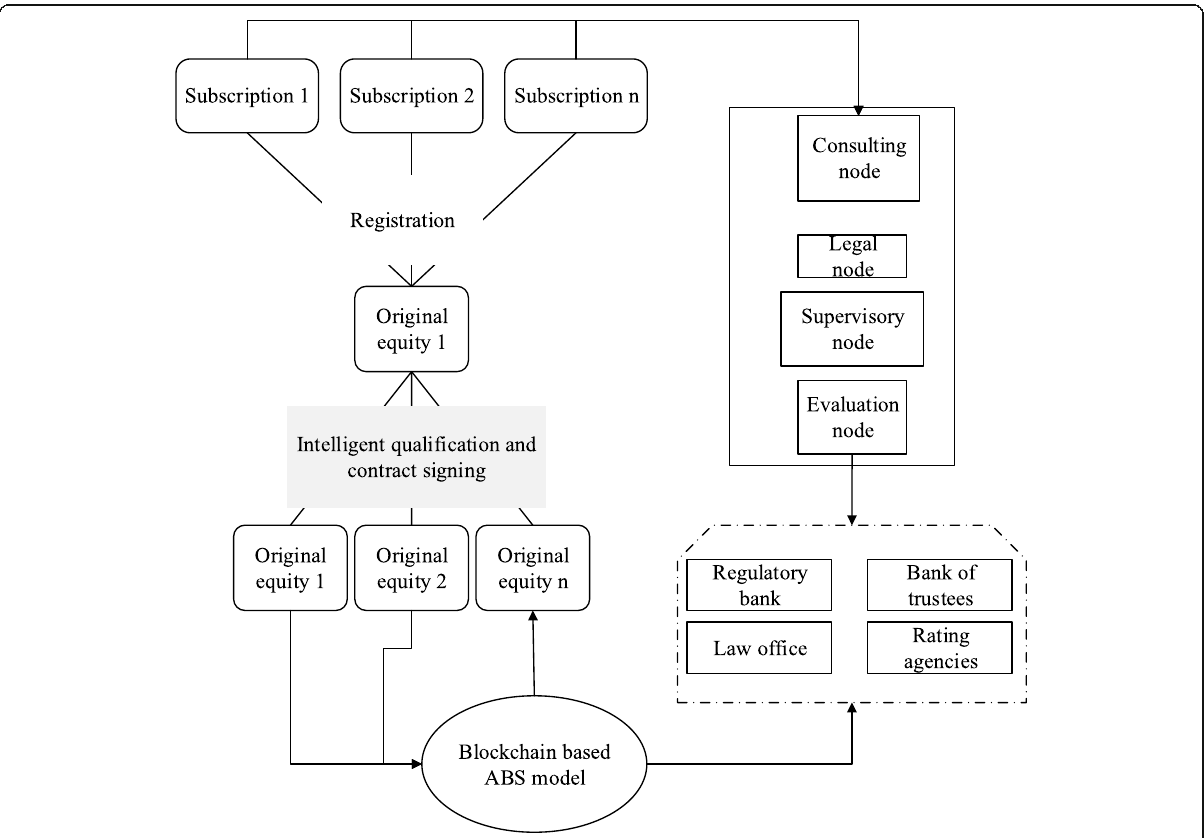
Fig. 6 Block chain-based Internet consumer financial asset